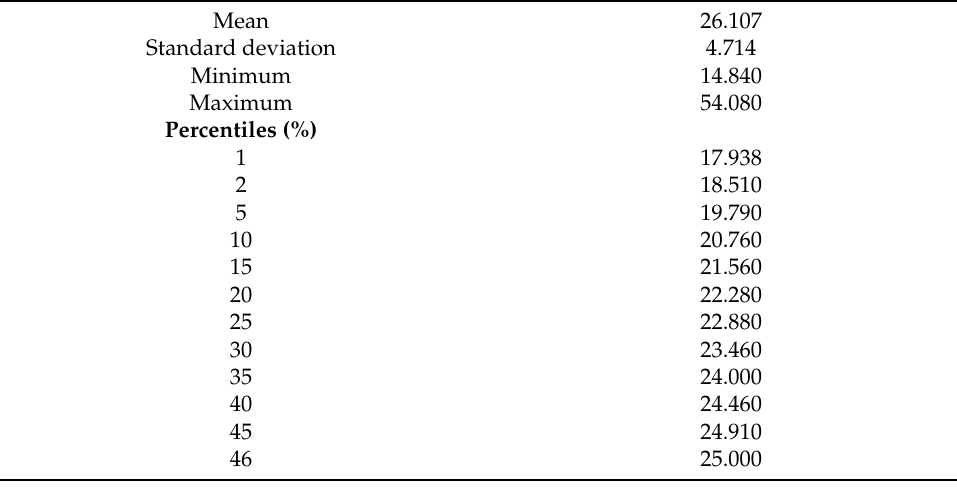
Table 1. BMI distribution (N =